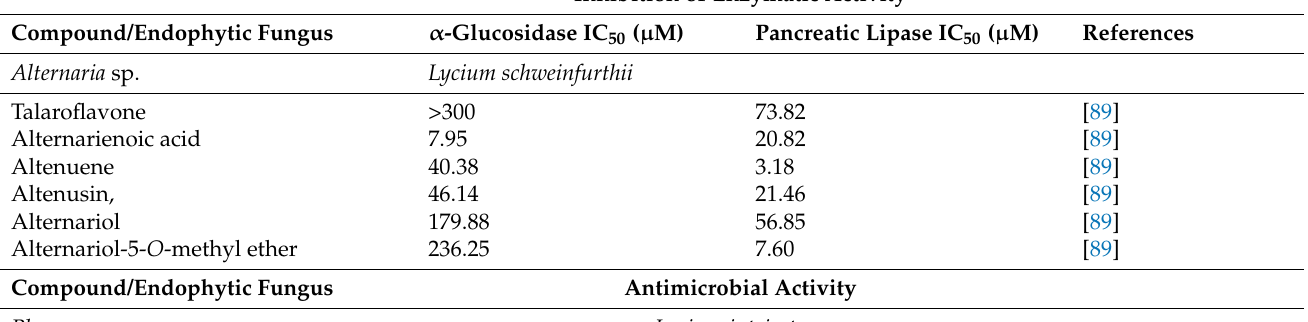
Table 2. Biological properties found for some compounds isolated from endophytic fungi found in